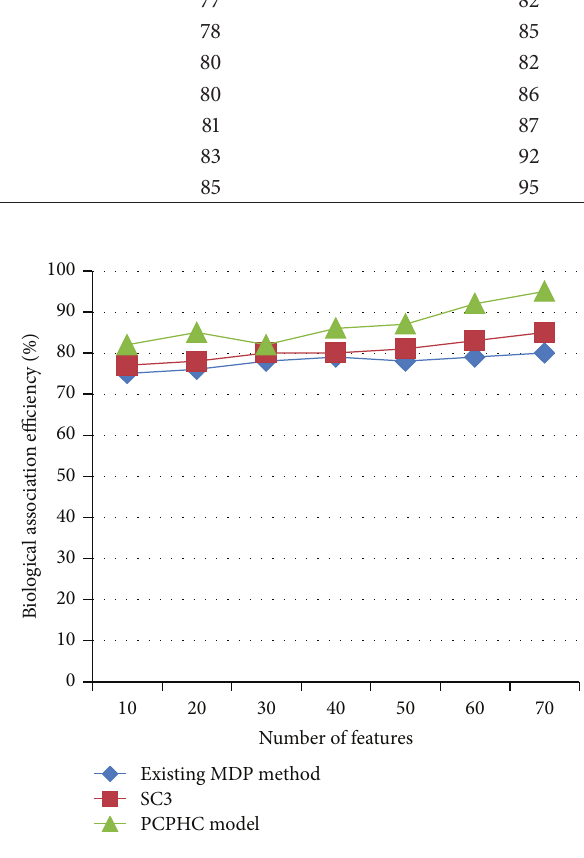
Figure 3: Measure of biological association efficiency (using yeast gene expression